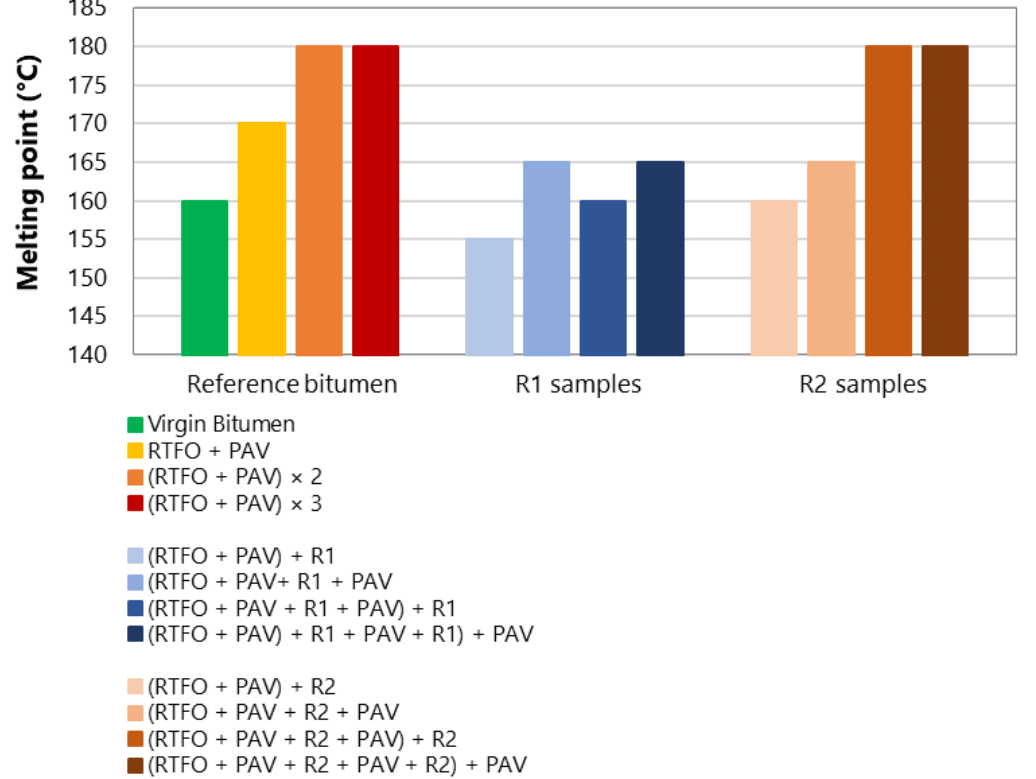
Figure 8. Melting point values of the asphaltenes extracted from each sample.